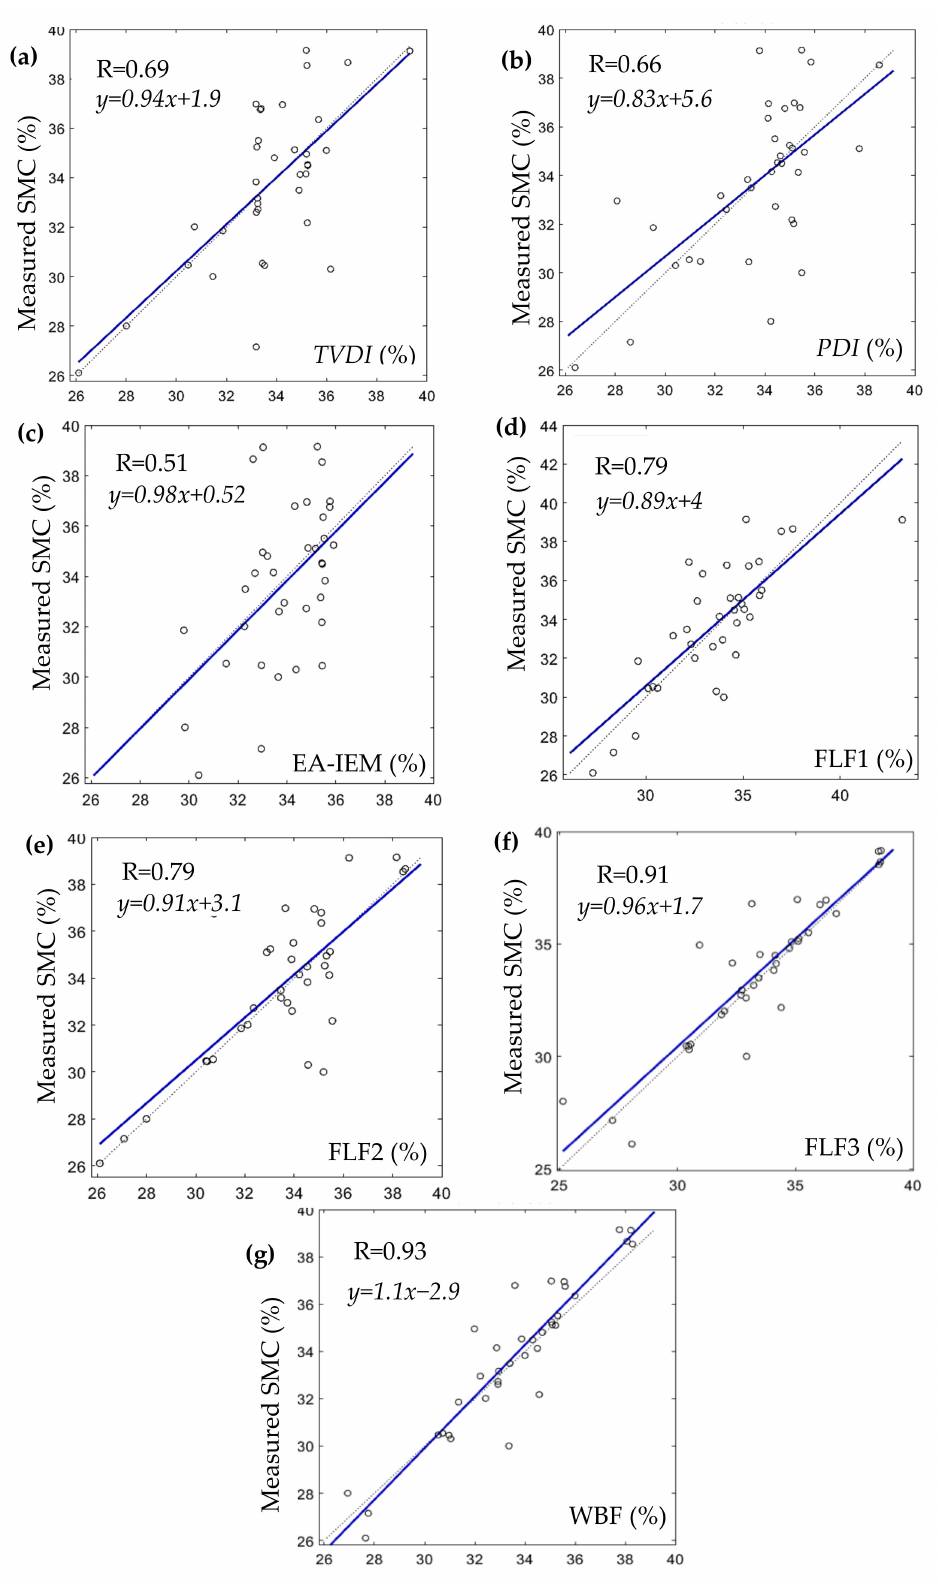
Figure 12. Results of each of the used SMC estimation methods in the Sidi Rached 2 dataset where: ( a ). TVDI. ( b ). PDI. ( c ). EA-IEM. ( d ). FLF1. ( e ). FLF2. ( f ). FLF3. ( g ).